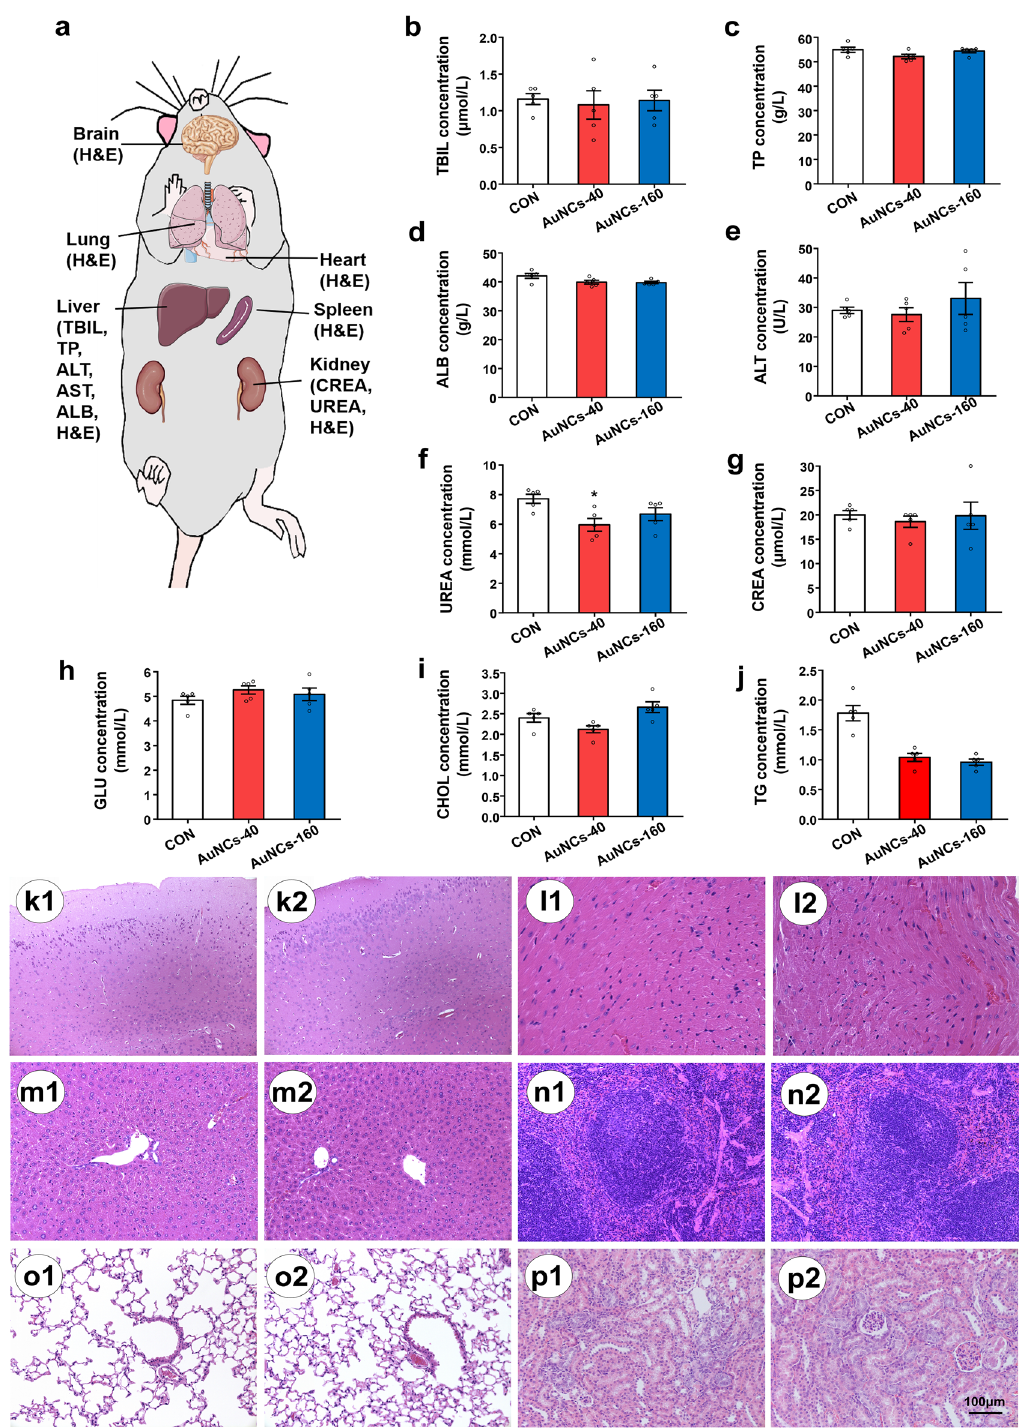
Figure 6. Toxic effects of AuNCs treatment for 28 days in mice. ( a ) Scheme of main organs and plasma biochemical markers that have been examined. ( b – j ) Plasma biochemical indexes after 28-day AuNCs treatment at dosages of 40 mg/kg and 160 mg/kg. ( k – p ) H&E stanning of mouse tissues including brain ( k ), heart ( l ), liver ( m ), spleen ( n ), lung ( o ) and kidney ( p ) after 28-day treatment of saline (1) or 160 mg/kg AuNCs (2). n = 5/ group. TBIL total bilirubin, TP total protein, ALB albumin, ALT alanine aminotransferase, CREA creatinine, GLU glucose, CHOL cholesterol, TG